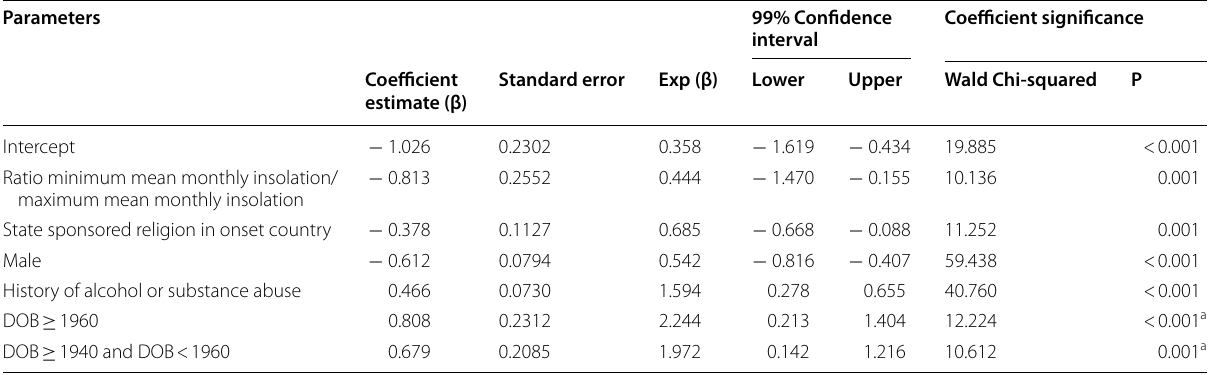
Table 5 Estimated parameters for alternative model explaining a history of suicide attempts for patients with bipolar I disorder (N =